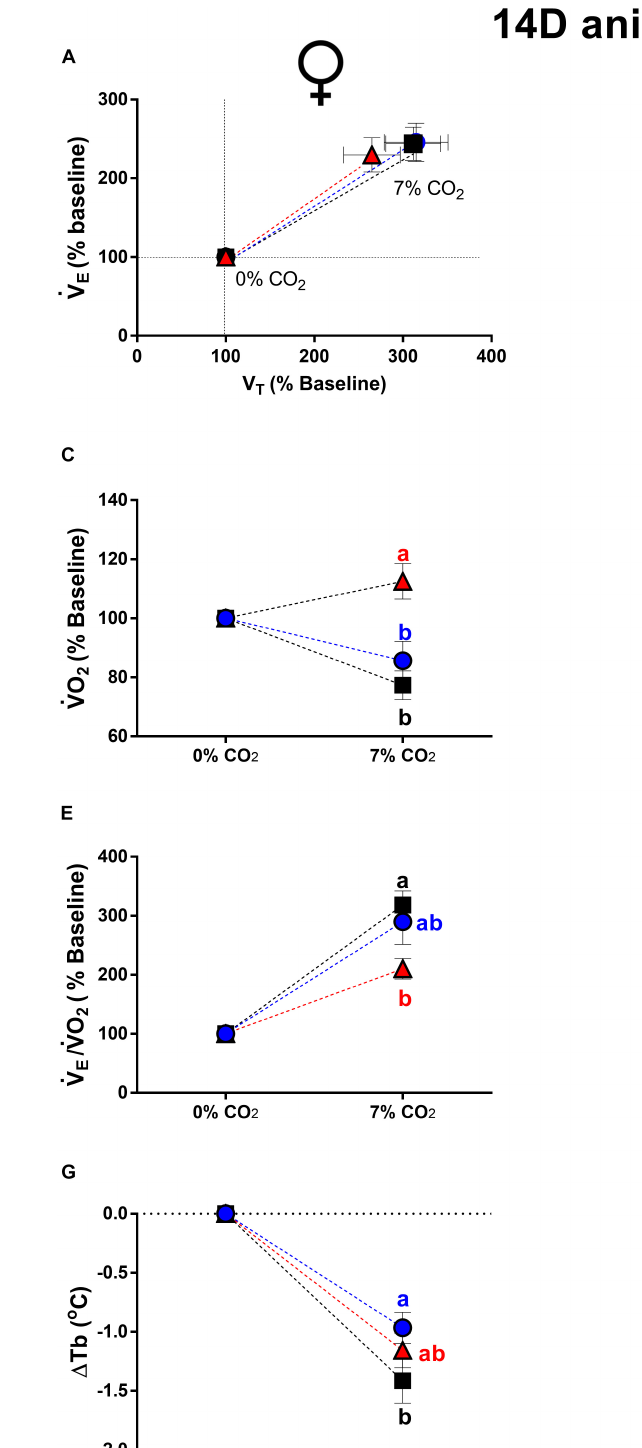
Frontiers in Physiology |